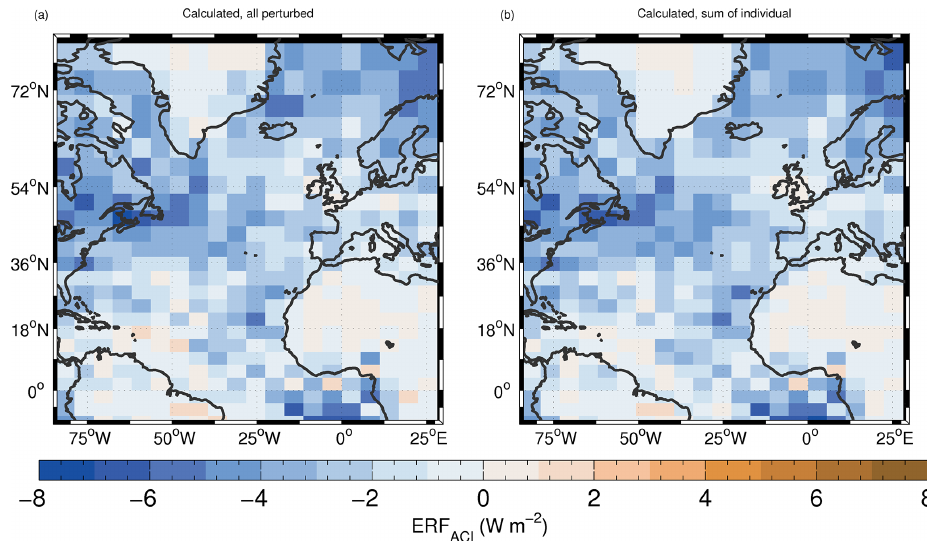
Figure 14. Time-mean surface ACI forcing (Wm − 2 ) calculated using different techniques. (a) Estimated surface ACI forcing calculated using the changes in LWP in-cloud , N d and cloud fraction between PD and PI simultaneously, according to Eq. (F13); (b) the sum of the estimated contributions from the individual changes (Eq.